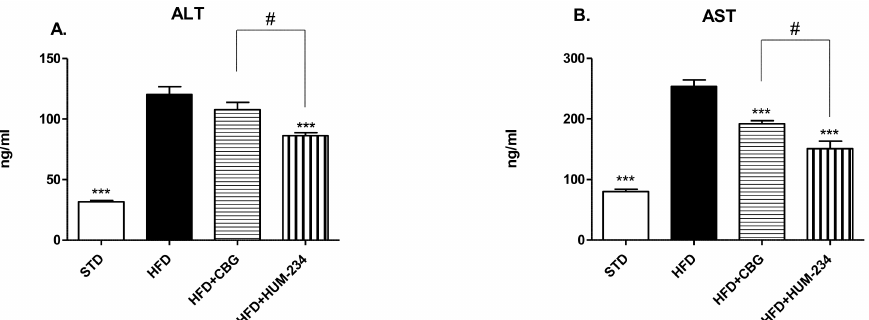
Figure 7. Liver enzymes evaluation of HUM-234 (25 mg/kg) in comparison to CBG (15 mg/kg), HFD (high fat diet) and STD (standard food diet). ( A ) ALT (Alanine transaminase) ( B ) AST (Aspartate transaminase). Statistical analysis by one-way ANOVA ( p -value < 0.0001 for both ALT and AST) and post hoc analysis by Tukey’s test. *** p < 0.001 comparing to HFD group. # p -value < 0.05 in the indicated